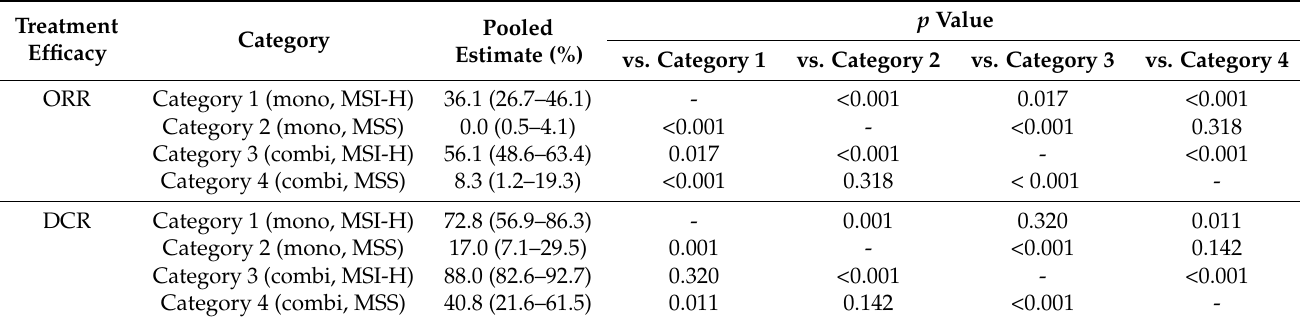
Table 4. Subgroup analyses according to the microsatellite phenotype and drug regimen in patients treated with ICIs as second- or more-line therapy.